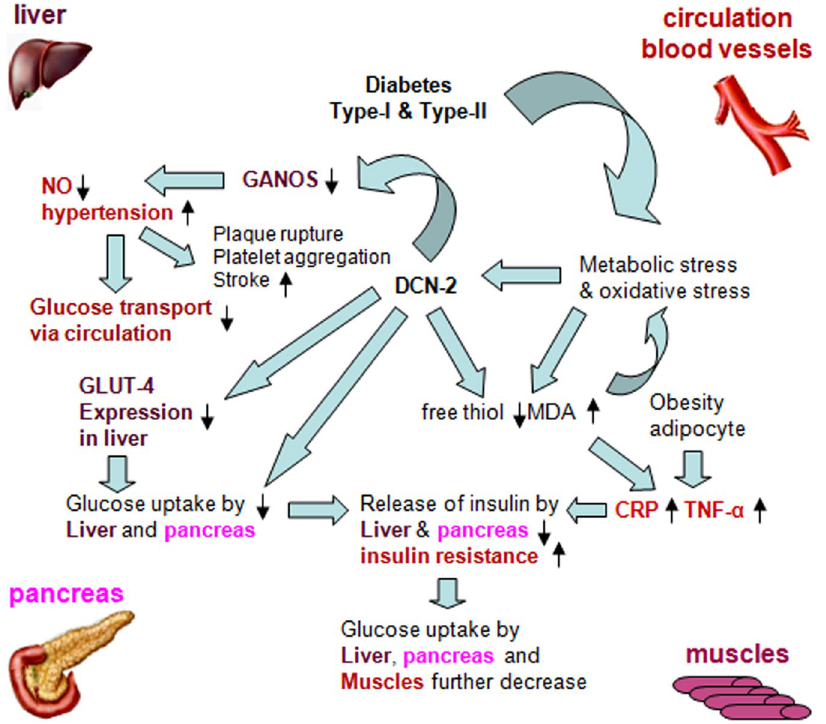
Figure 8. Diagrammatic representations of the role of human dermcidin isoform-2 (DCN-2) in the initiation of different metabolic dysregulations. Stress-induce protein DCN-2 disrupts glucose and lipid homeostasis by down-regulating NOS expression and up-regulating CRP and TNF- α